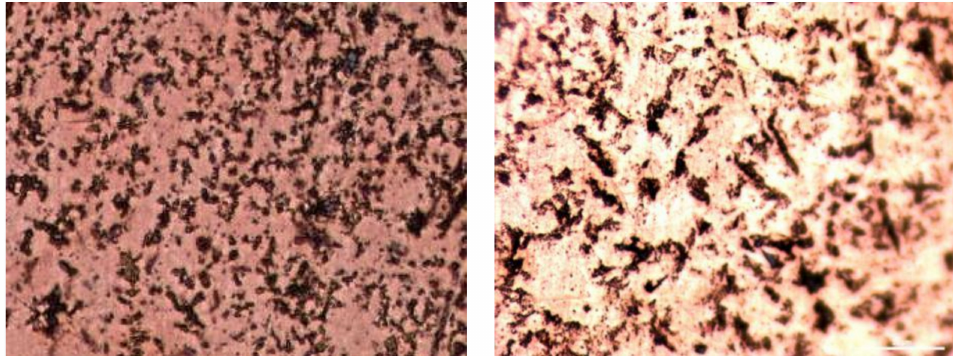
Figure 1. Metallographic structure of copper staves: ( a ) amplification factor, 60; ( b ) amplification factor, 150.